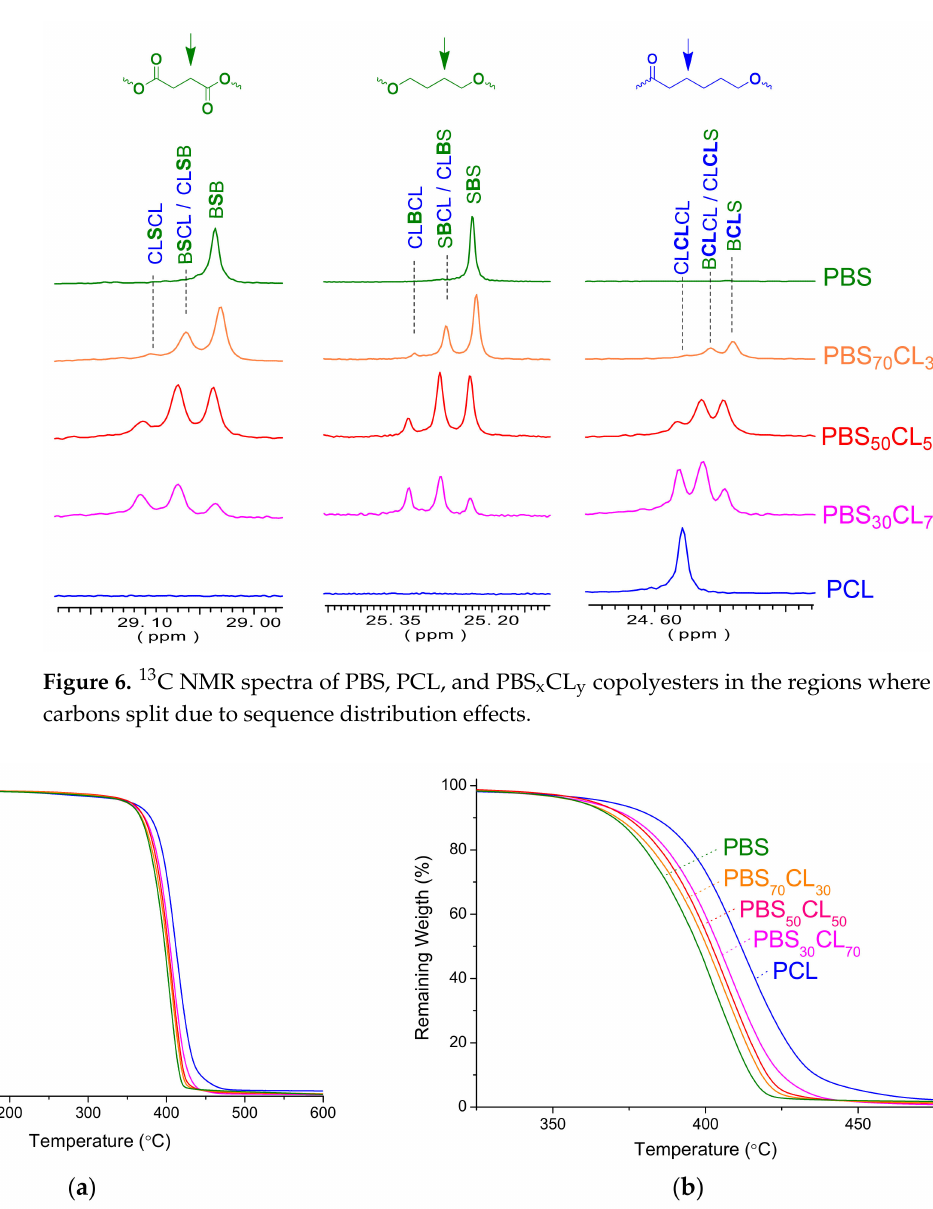
Figure 7. For a clearer illustration of the observed trend, the 325–475 ◦ C region is expanded in Figure 7b.